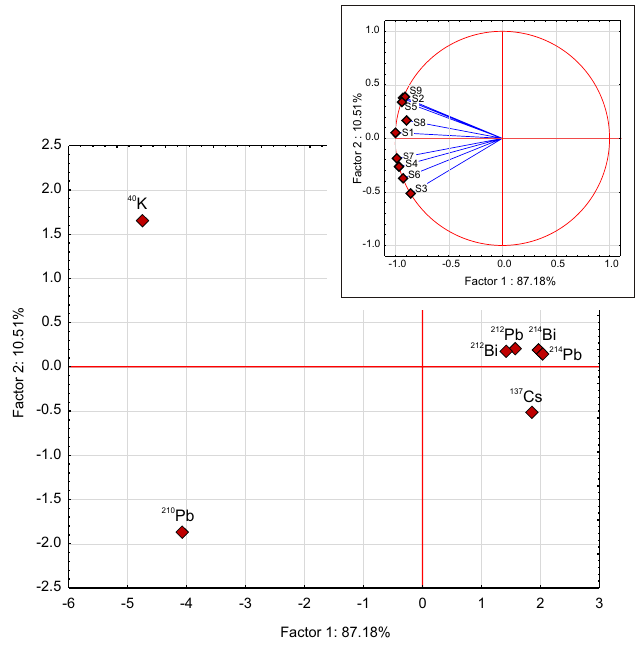
Figure 3. The result of PCA of the activity concentration of investigated